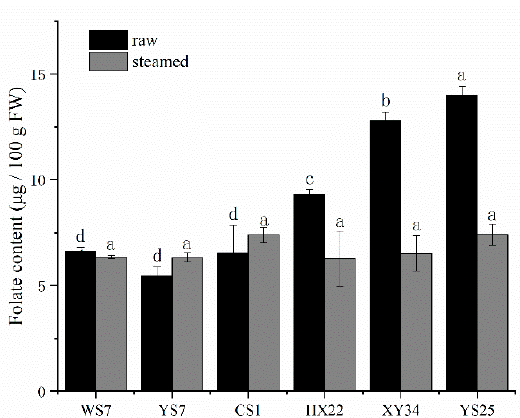
Figure 2. Effect of thermal processing on folate content changes in sweet potato roots (SPRs). Notes: Turkey tests were carried out in each row and bars with different letters differ significantly at p < 0.05.